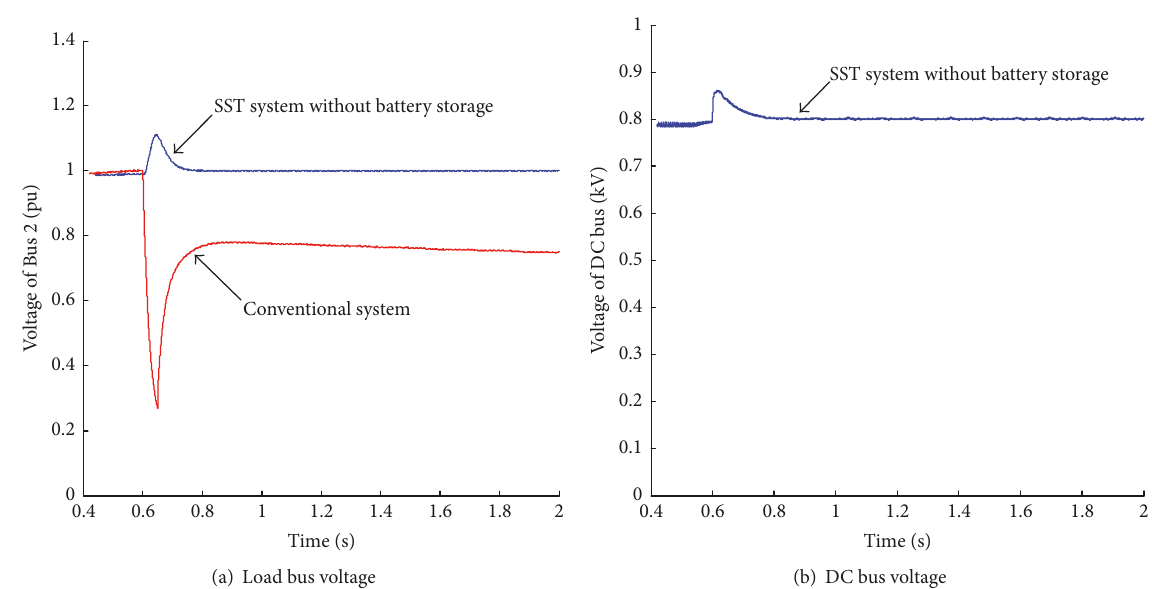
Figure 7: Response curves when three-phase short circuit fault occurs at the midpoint of Line 2.